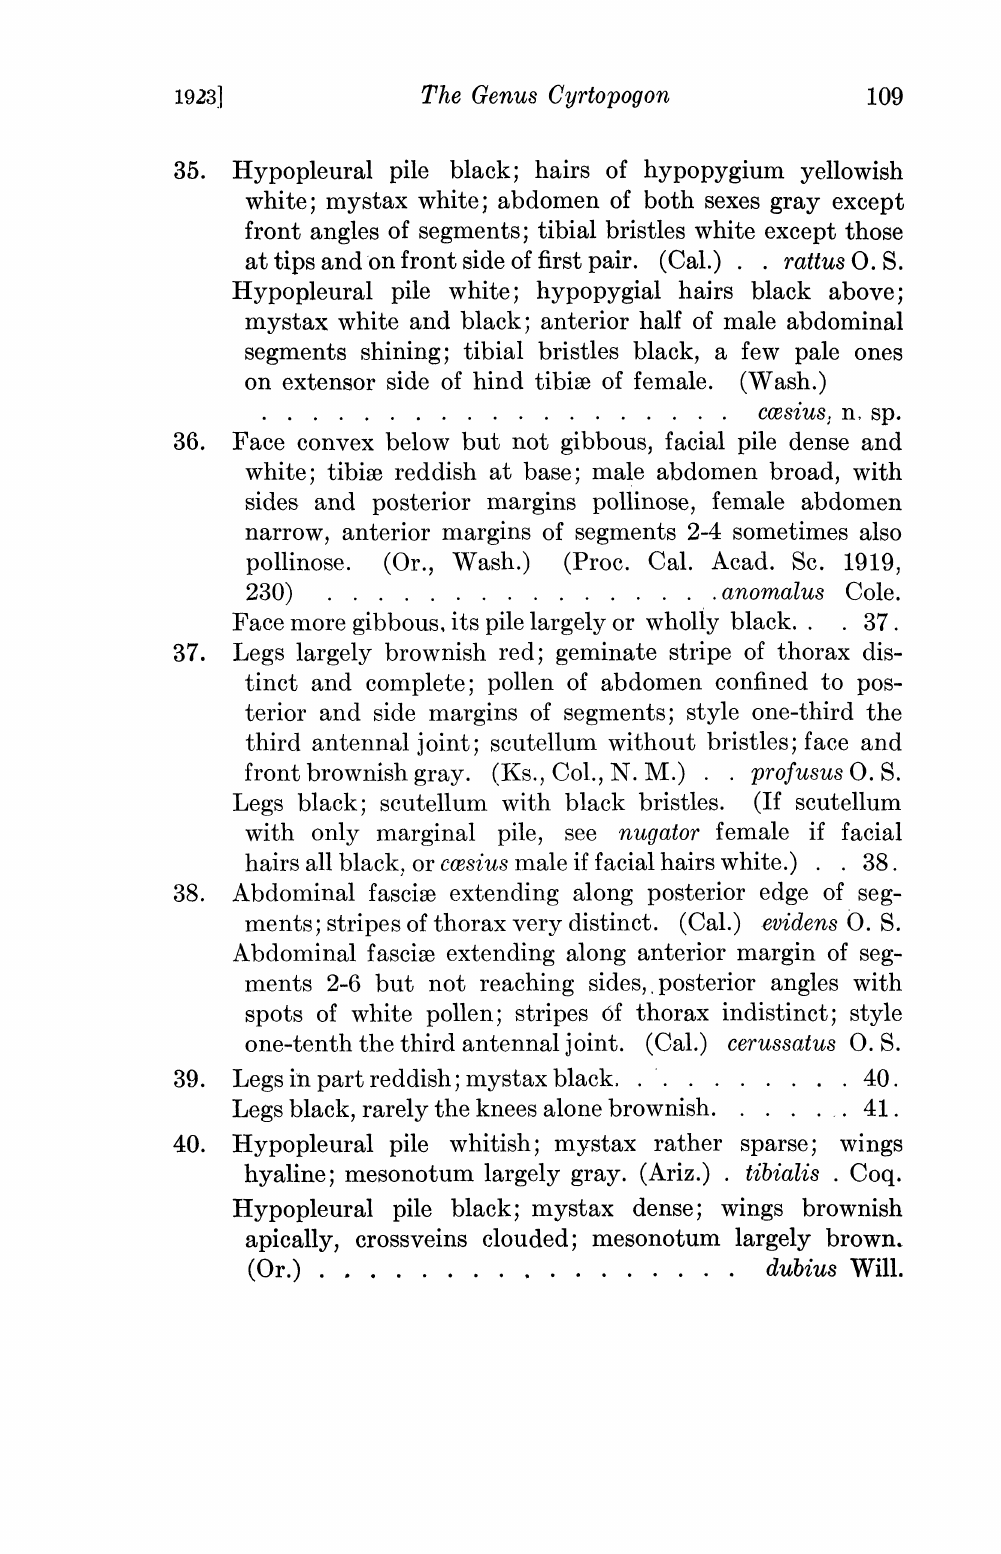
Hypopleural pile black; hairs of hypopygium yellowish white; mystax white; abdomen of both sexes gray except front angles of segments; tibial bristles white except those at tips andon front side of first pair. (Cal.) Hypopleural pile white; hypopygial hairs black above; mystax white and black; anterior half of male abdominal segments shining; tibial bristles black, a few pale ones on extensor side of hind tibiae of female. 36. Face convex below but not gibbous, facial pile dense and white; tibim reddish at base; male abdomen broad, with sides and posterior margins pollinose, female abdomen narrow, anterior margins of segments 2-4 sometimes also pollinose. Legs largely brownish red; geminate stripe of thorax dis- tinct and complete; pollen of abdomen confined to pos- terior and side margins of segments; style one-third the third antennal joint; scutellum without bristles; face and front brownish gray. (Ks., Col., N.M.) Legs black; scutellum with black bristles. with only marginal pile, see nugator female if facial hairs all black, or ccesius male if facial hairs white.) Abdominal fascim extending along posterior edge of seg- ments; stripes of thorax very distinct. (Cal.) evidens O. S. Abdominal fascim extending along anterior margin of seg- ments 2-6 but not reaching sides, posterior angles with spots of white pollen; stripes Of thorax indistinct; style one-tenth the third antennal ioint. (Cal.) cerussatus O.S. 39. Legs in part reddish; mystax black.. Legs black, rarely the knees alone brownish 40. Hypopleural pile whitish; mystax rather sparse; wings hyaline; mesonotum largely gray. (Ariz.) tibialis Coq. Hypopleural pile black; mystax dense; wings brownish apically, crossveins clouded; mesonotum largely brown. (Or.) dubius